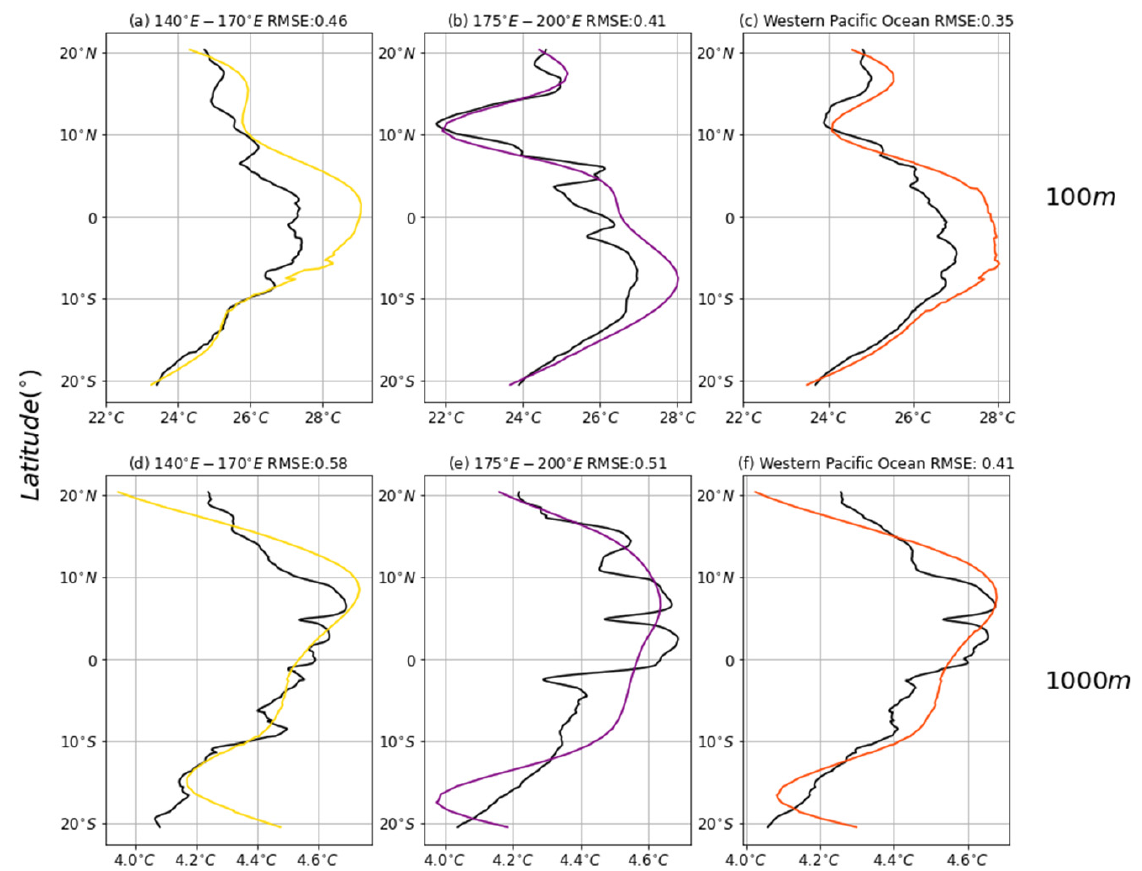
Figure 7. OST profiles at 100 m and 1000 m. The warm pool ( a , d ), the low temperature region ( b , e ), and the whole western Pacific Ocean ( c , f ). The black lines indicate the estimated OST and the colored lines indicate the Argo-observed OST.